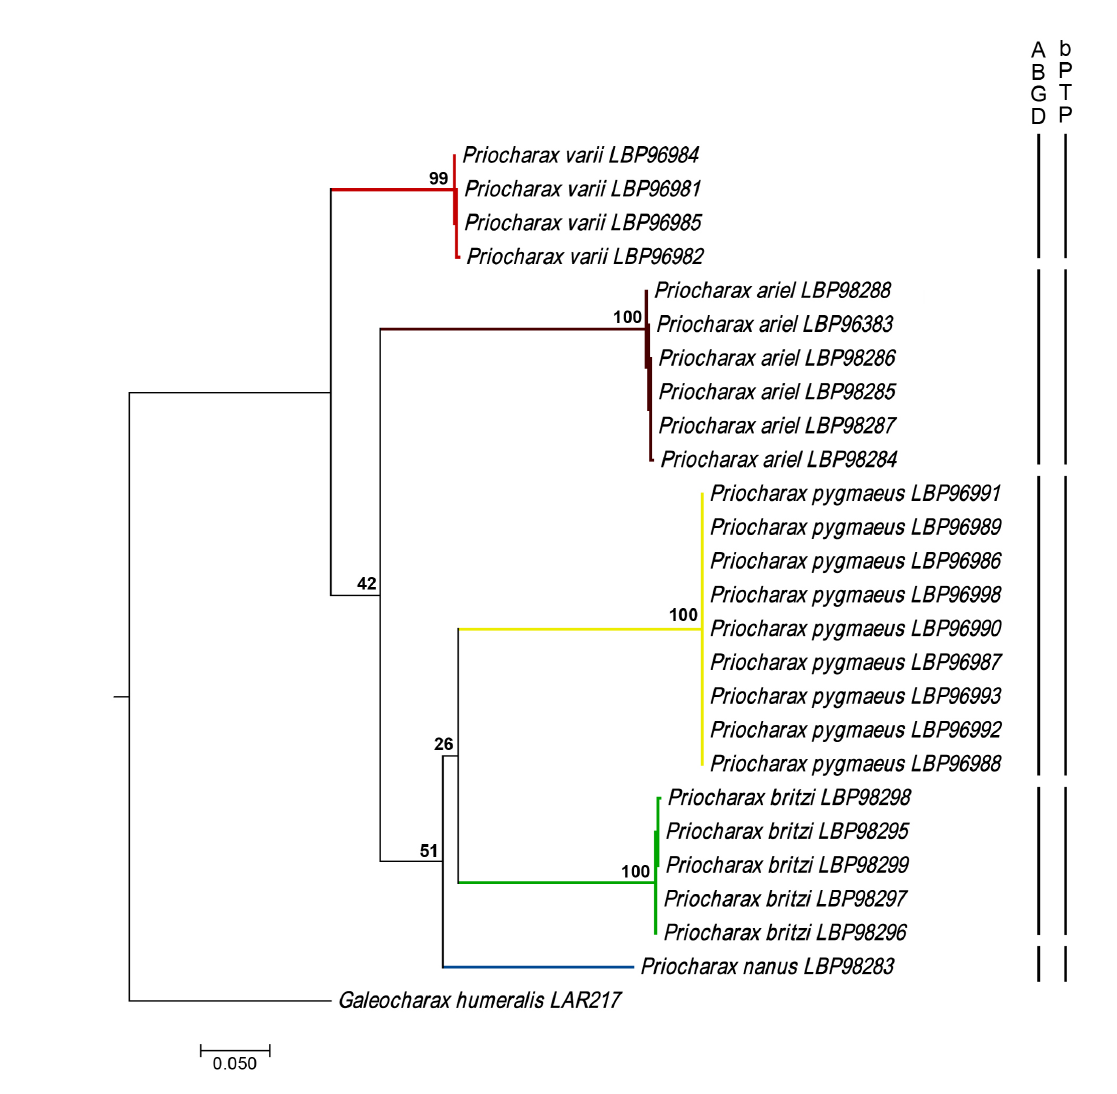
FIGURE 7 | Maximum likelihood tree of five species of Priocharax , based on the COI gene (642 bp). Bars represent the number of species obtained by the ABGD and bPTP analyses. Numbers near nodes represent bootstrap values.